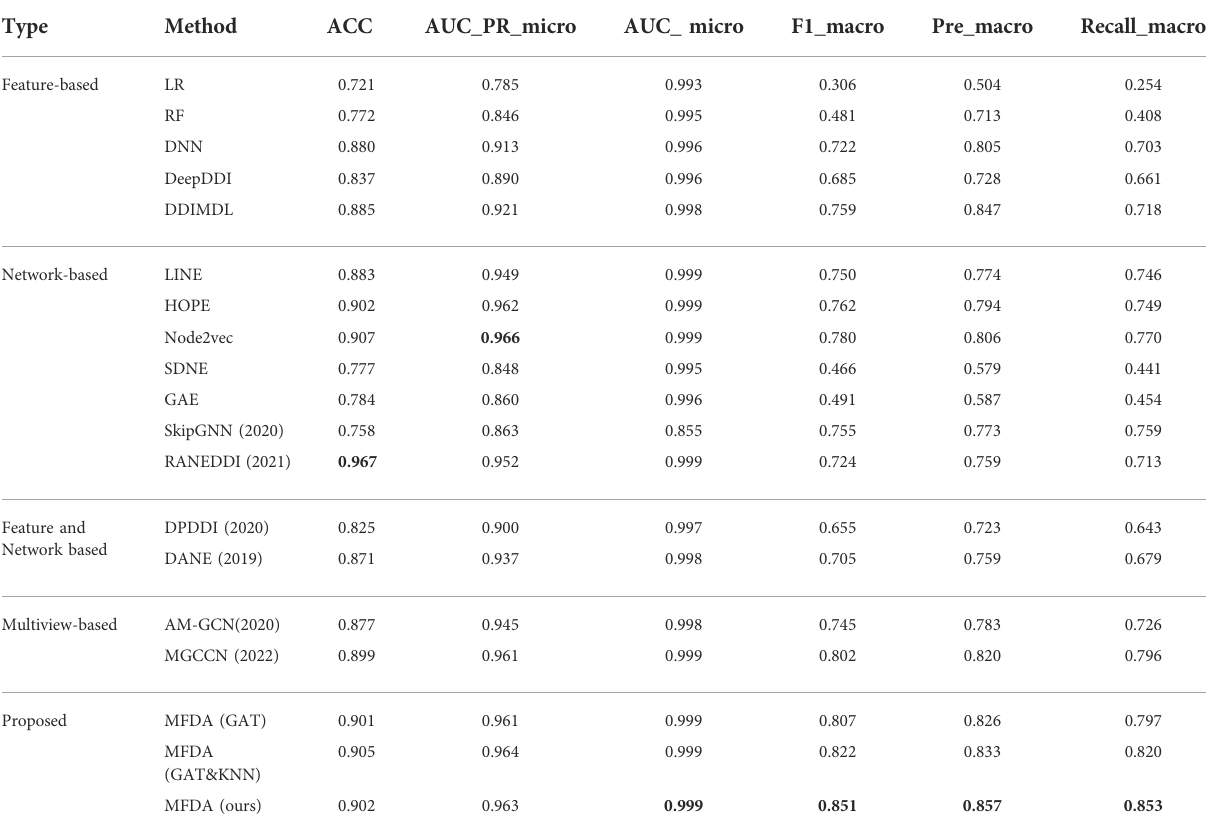
TABLE 4 Performance of our model against competitive